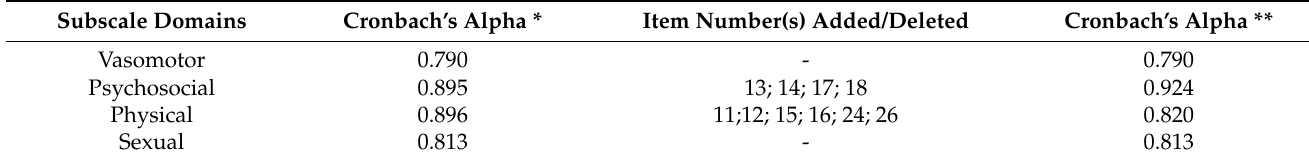
Table 3. Internal consistency